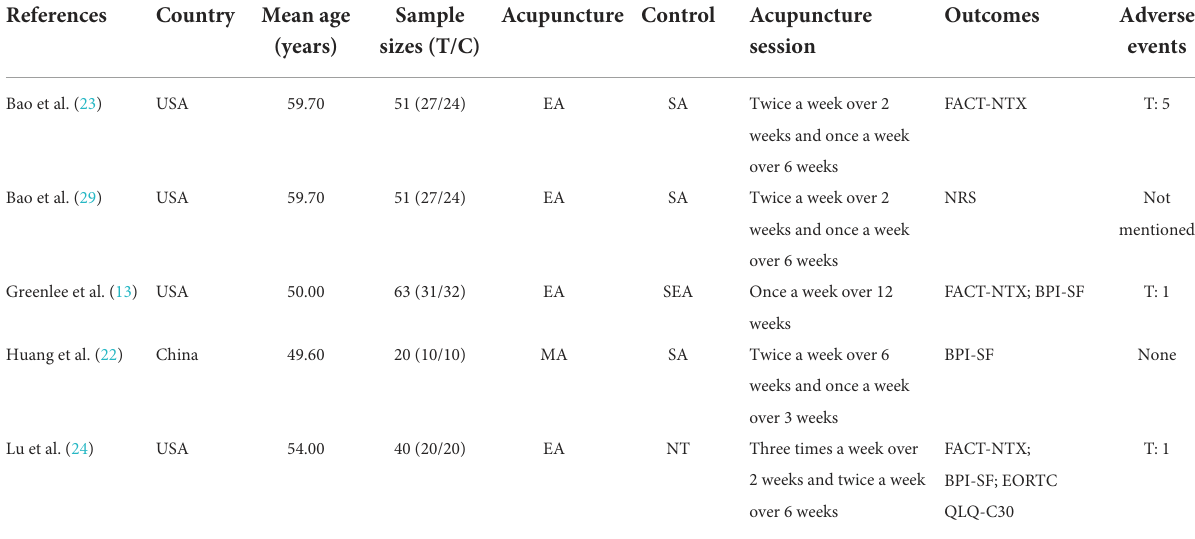
TABLE 1 The characteristics of the included